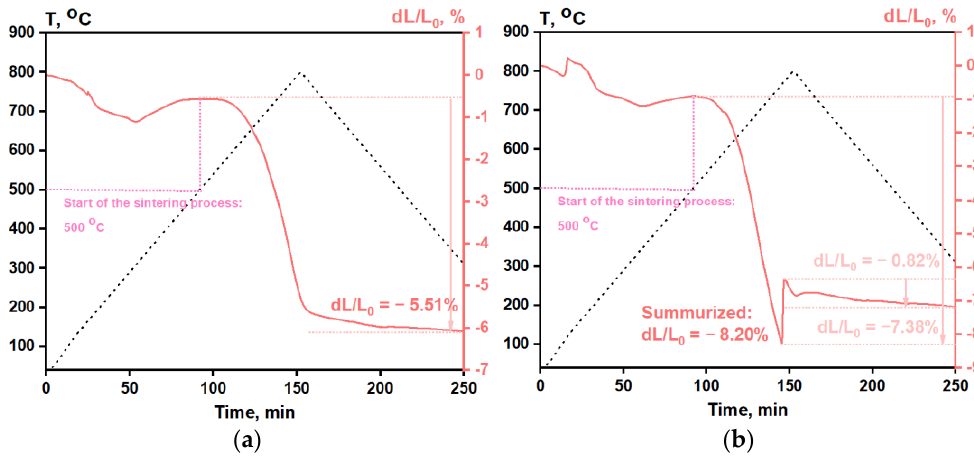
Figure 13. Shrinkage curves for ( a ) Mg20K and ( b ) Mg20KY-TZP. According to the dilatometry, the sintering process started at the same temperature for Mg20K and Mg20KY-TZP, but the final dL/L 0 value for the zirconia-containing sample was − 8.2%, while for the Mg20K sample the value dL/L 0 was equal to − 5.51%. The rapid growth in the dL/L 0 for K20Y-TZP sample in the interval of 140–150 min occurred as a result of minor cracking of the sample. The better densification could be explained by the slower grain growth due to the presence of zirconia nanoparticles. For the sodium-containing samples, this process was more complicated, as the sintering temperature was much closer to the melting point of the mixed sulfate phase. According to the TG (Figure S4) for the Mg20KY-TZP sample, two endo peaks were observed at temperatures of 575 and 750 ◦ C. They correspond to the eutectic temperatures in the corresponding phase diagram [48]. The peak at 750 ◦ C was very broad and asymmetrical with a cut-off at 752 ◦ C, which could be regarded as corresponding to the solid-state reaction between K 2 SO 4 and MgSO 4 , leading to the formation of K 2 Mg 2 (SO 4 ) 3. The resulting 3D molds are demonstrated in Figure